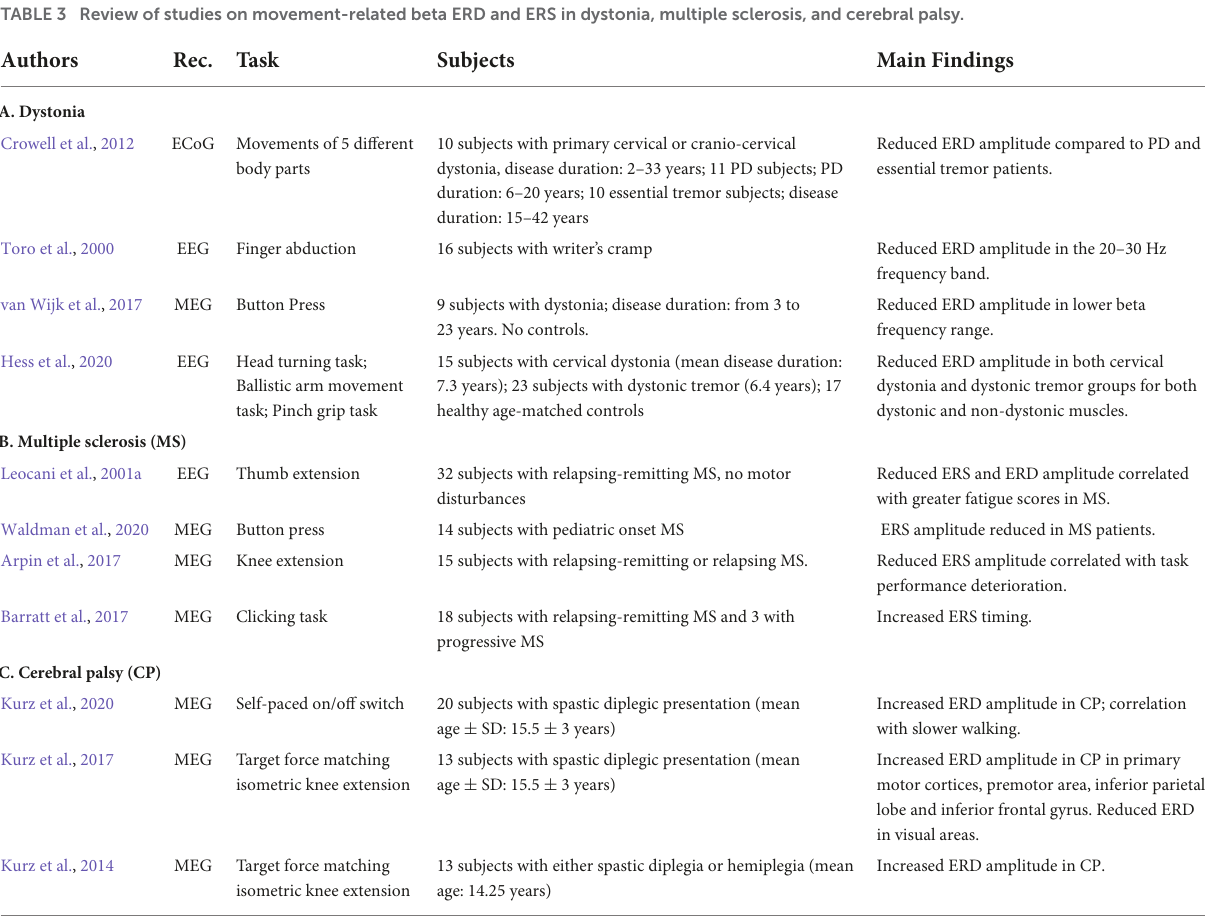
TABLE 3 Review of studies on movement-related beta ERD and ERS in dystonia, multiple sclerosis, and cerebral